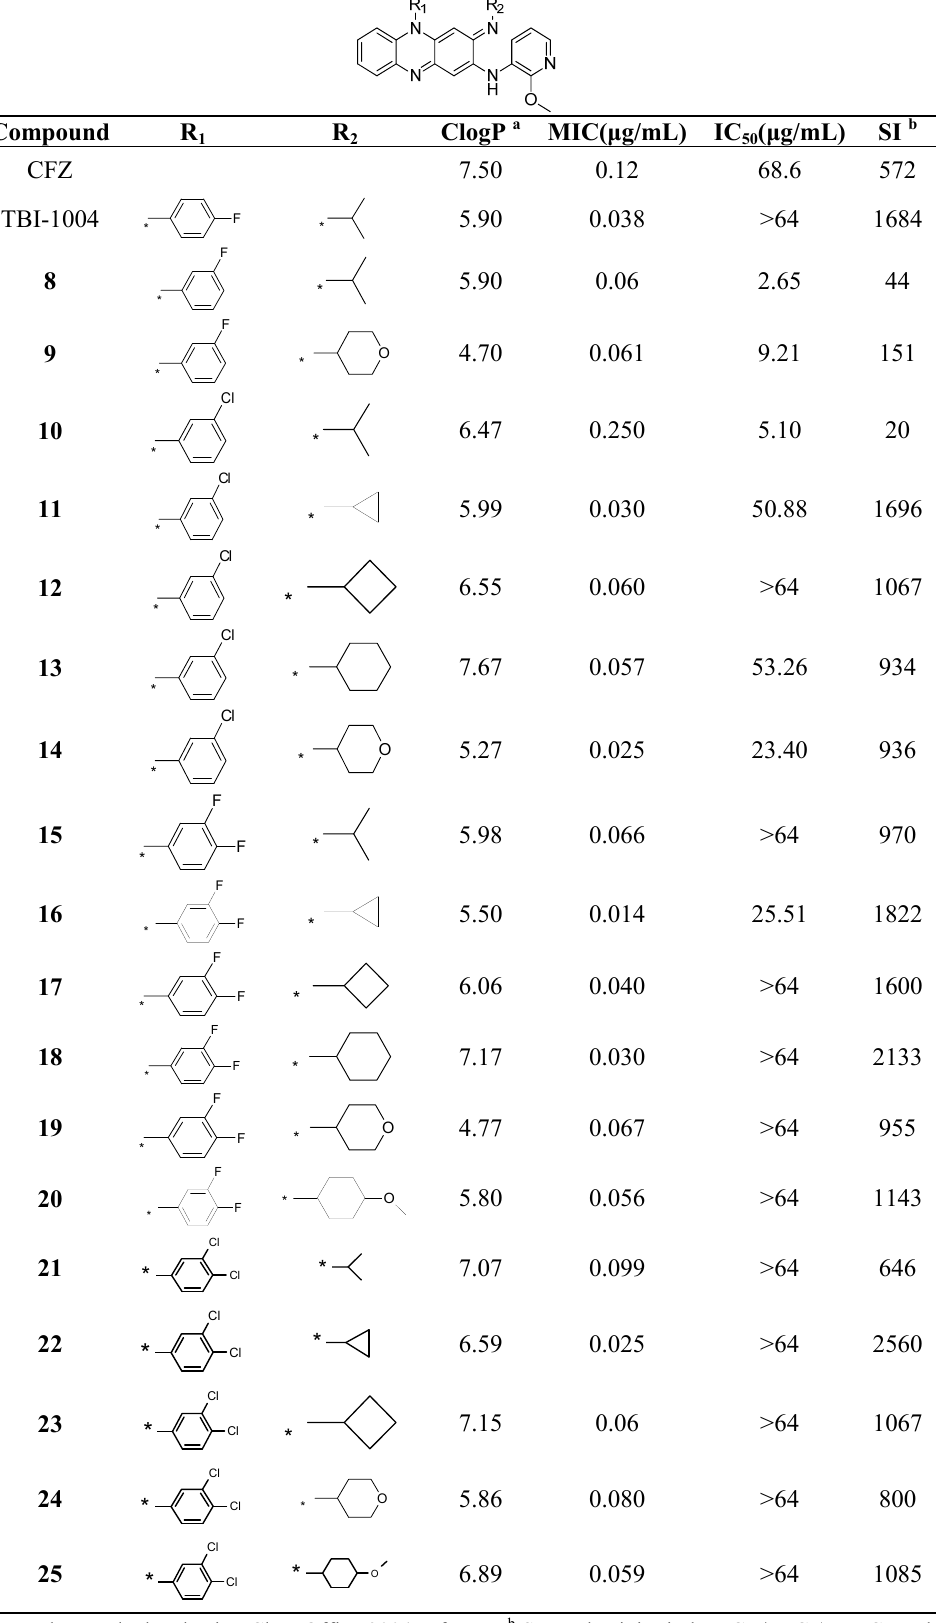
Table 1. Physicochemical property (ClogP), antituberculosis activity (MIC), cytotoxicity (VERO IC ), and selectivity index (SI) values for target 50